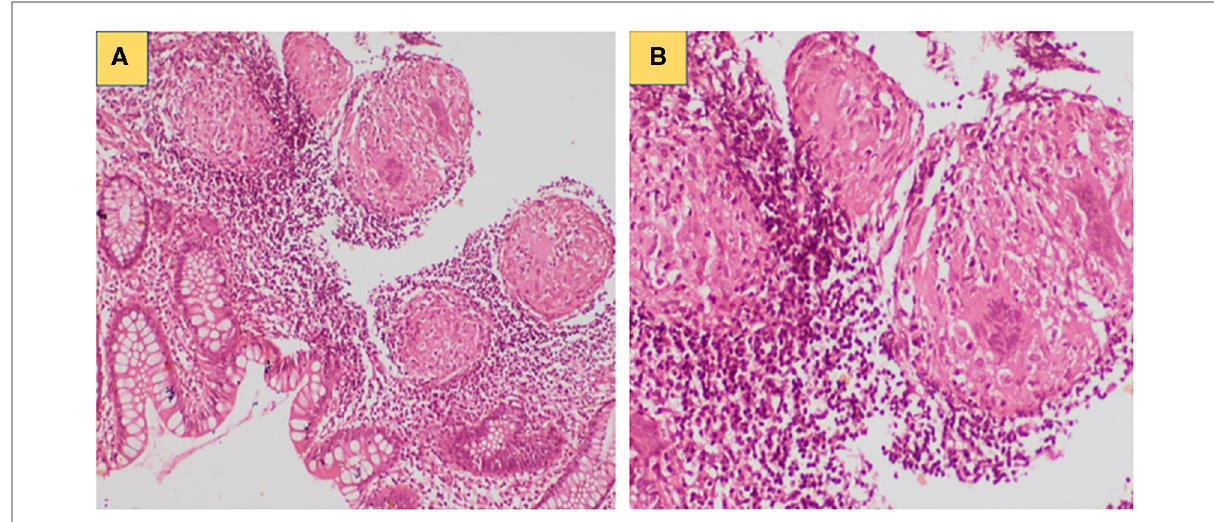
FIGURE 1 ( A ) Colonic biopsy showing focal excess of mononuclear in fl ammatory cells with increased number of eosinophils in lamina propria; ( B ) Compact non-caseating granuloma noted in the colonic